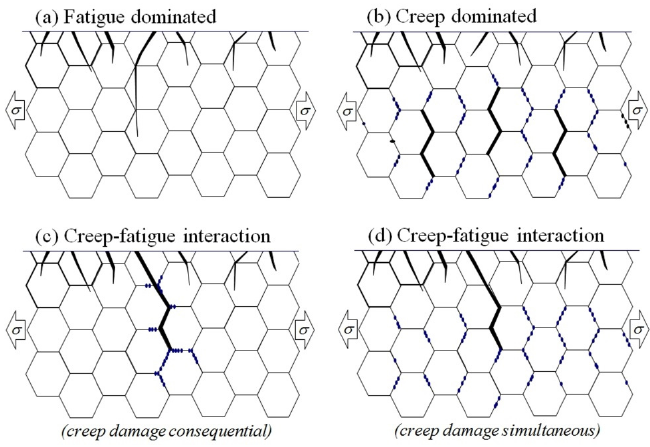
Figure 1. Creep ‐ fatigue cracking mechanisms: ( a ) fatigue dominated; ( b ) creep dominated; ( c ) creep ‐ fatigue interaction (due to “simultaneous” creep damage accumulation); ( d ) creep ‐ fatigue interaction (due to “consequential” creep damage accumulation).